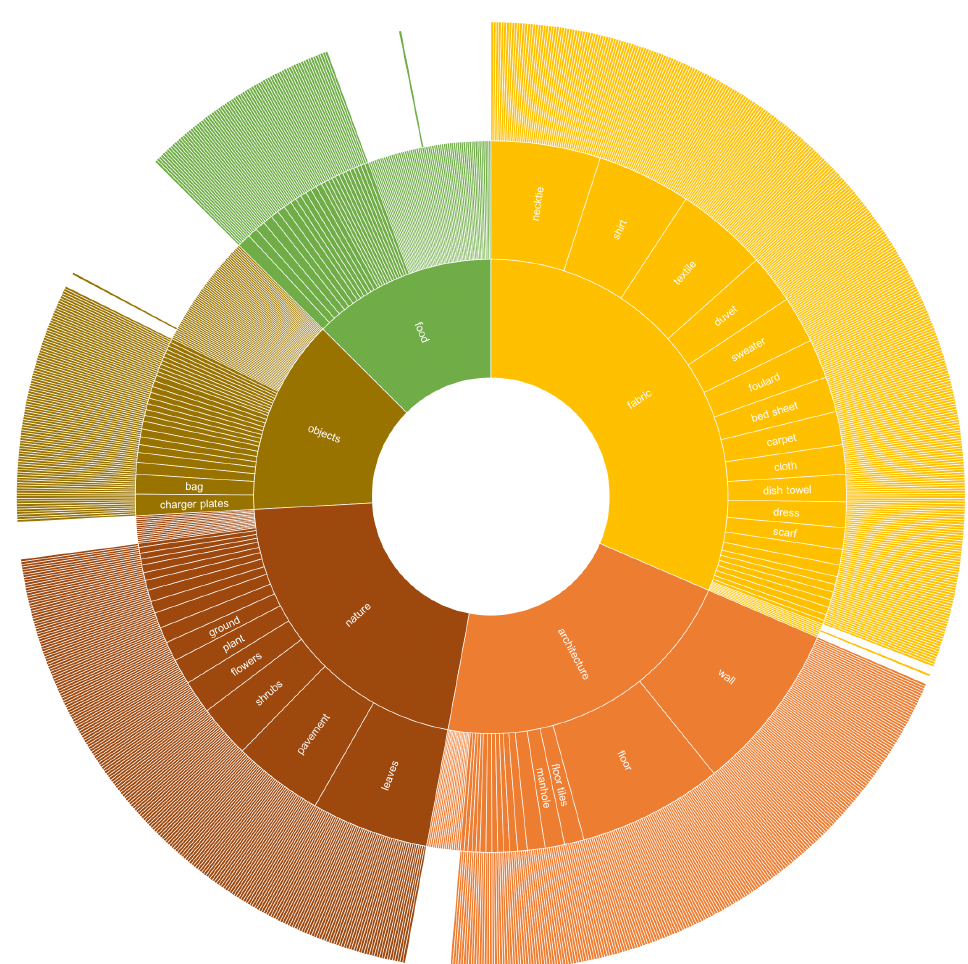
Figure 3. Hierarchical representation of T1K+ texture classes. The first ring is composed of five classes: nature, architecture, fabric, food, and objects. The second ring is composed of 266 classes: wall, floor, shirt, flowers, pavement, textile, and many others. The last ring is composed of 1129